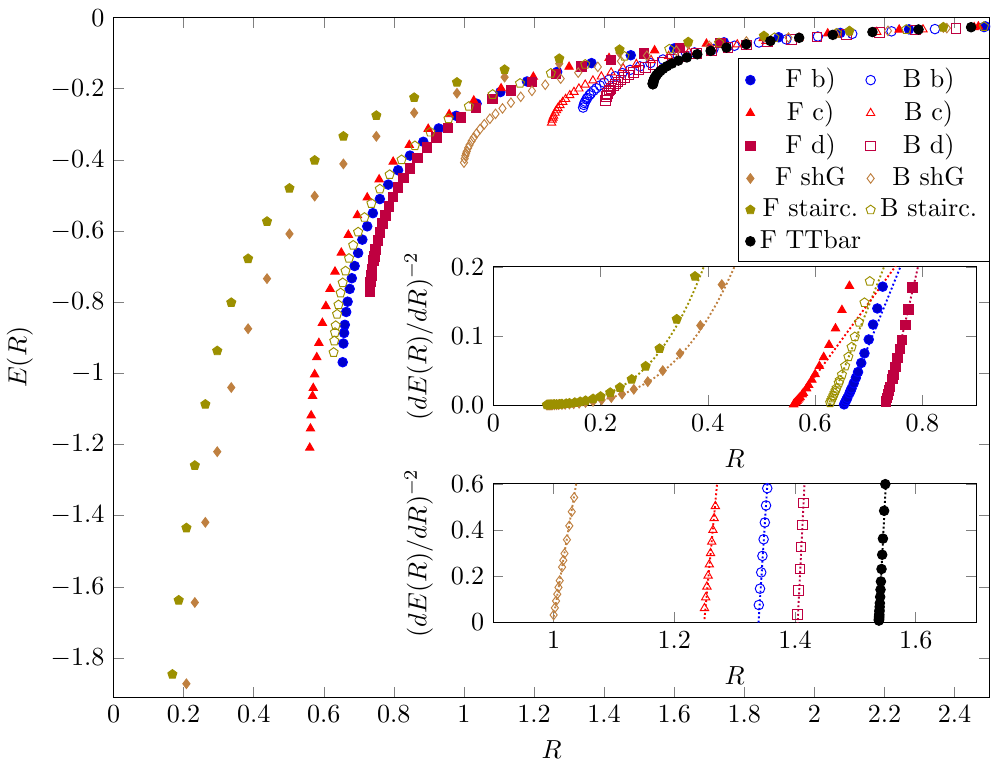
Figure 4. Ground-state energies for the various models discussed above, along with that of the ¯ T T -deformed free fermion (black dots). The empty (resp. filled) markers correspond to models with bosonic (resp. fermionic) statistics. The fermionic sinh-Gordon and staircase models can be solved iteratively all the way to the R → 0 limit, while the rest fail to converge below a certain model-specific scale R . The parameters of the models were chosen as to allow a comfortable visual ∗ comparison between the curves and are the same for both bosonic and fermionic versions of the same model. Insets: inverse square of the (numerical) derivative. As shown by the fits (dotted lines), the fermionic sinh-Gordon and staircase models show the conventional UV behavior ∝ R 4 , while the other models develop a ∝ R behavior reminiscent of the square-root branching singularity of the ground state